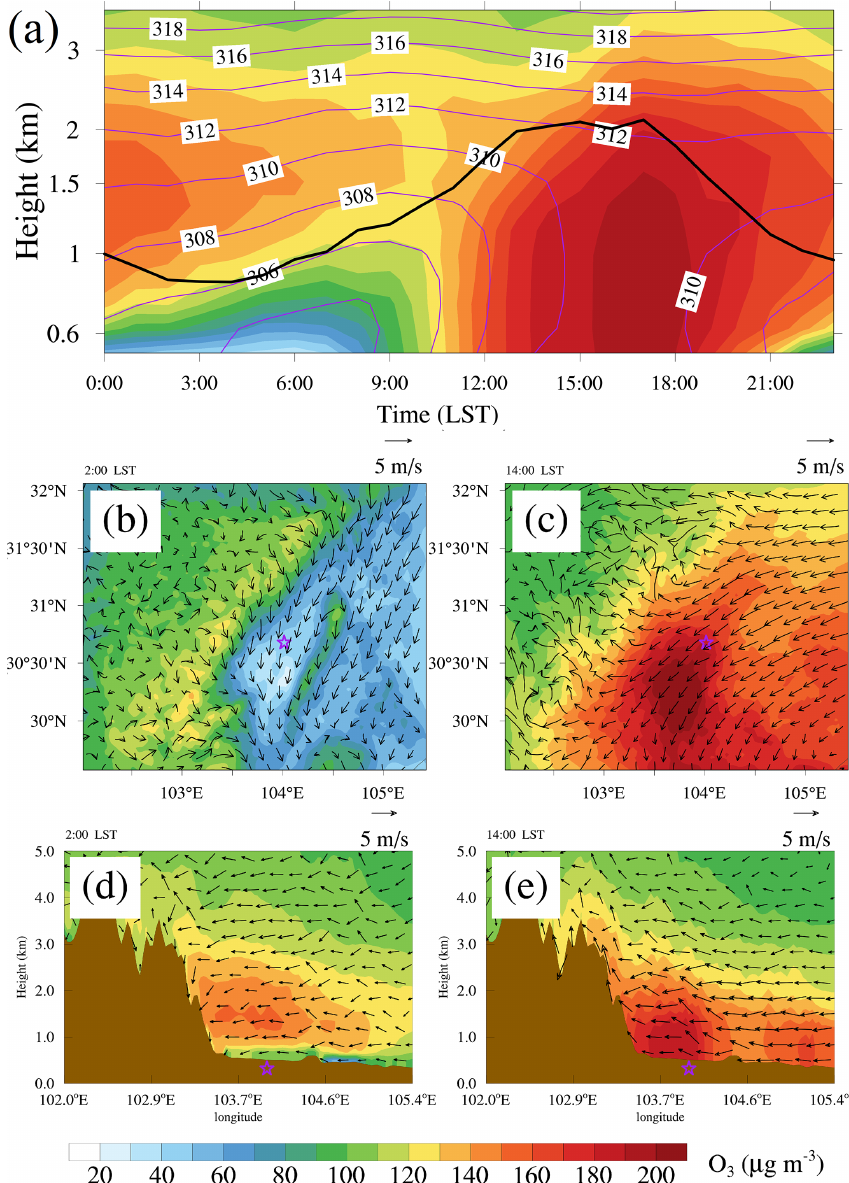
Figure 8. (a) Time–altitude cross sections of O 3 (colored shading), potential temperature (purple contour lines) and boundary layer height (thick black contour lines) at Chengdu. Panels (b) and (c) present the horizontal distributions of O 3 with wind vectors at the lowest model level at 02:00 and 14:00LST, respectively. Panels (d) and (e) present east–west vertical cross sections of O 3 with wind vectors at 02:00 and 14:00LST, respectively. Purple stars show the locations of Chengdu. Brown shaded areas represent the terrain. These results are the monthly average based on the July_Base